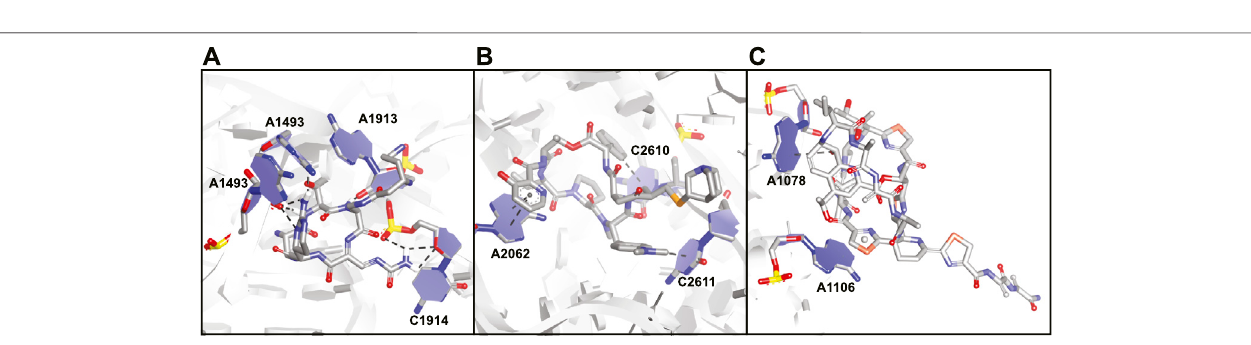
FIGURE13 | Crystal structures of antibiotic peptidesbound tothe ribosome. (A) Capreomycin ( 31 ) bound to the 16SrRNA (PDB ID — 4V7M). (B) Quinupristin ( 32 ) bound to the 23S rRNA (PDB ID — 4U26). (C) Thiostrepton ( 33 ) bound to the 23S rRNA (PDB ID — 3CF5).